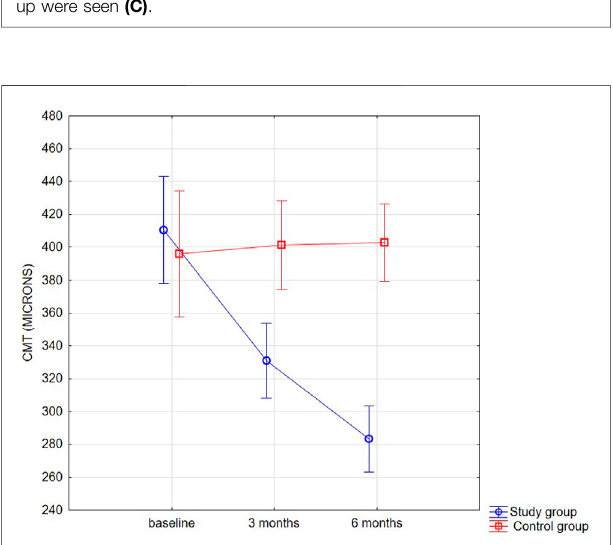
FIGURE3| Distribution plotforCMT( µm )meanvaluesinbothgroupsat baseline and 3 and 6